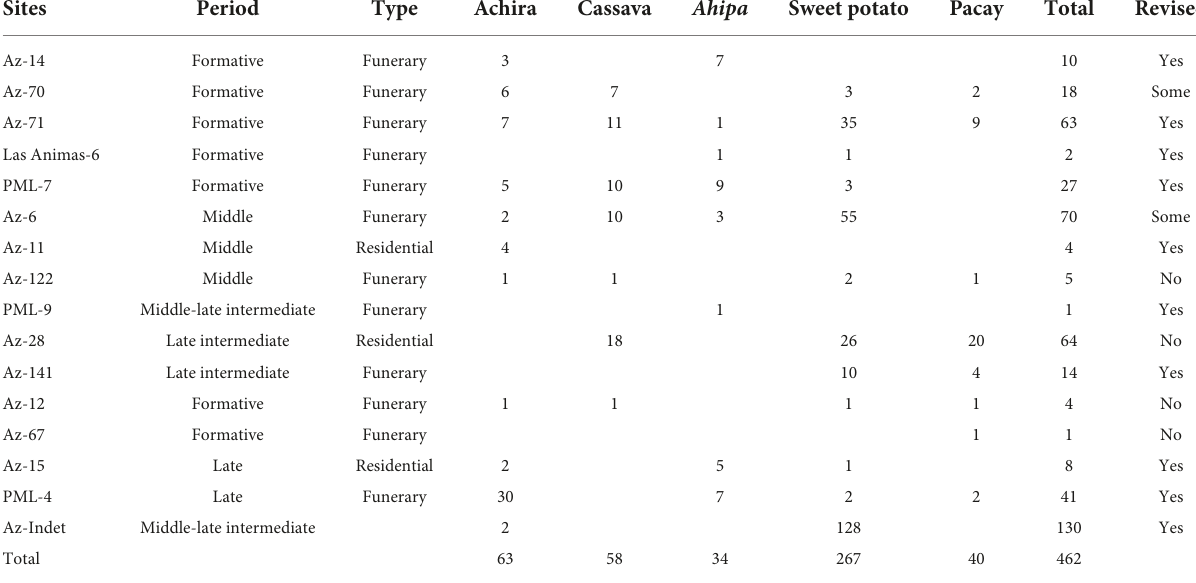
TABLE 2 Identified specimens in records from sites in the Azapa valley observed MASMA collections including counts of analyzed